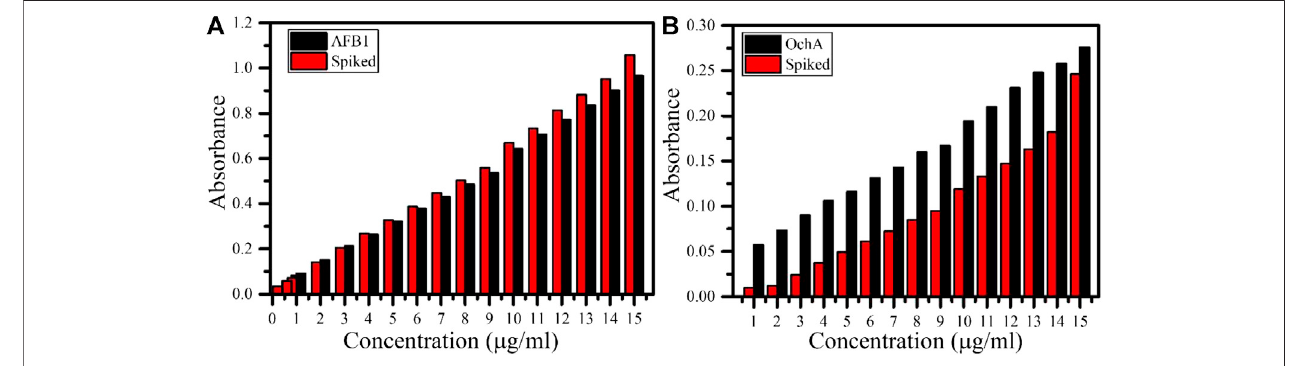
FIGURE 7 | Spiked corn sample study in comparison of (A) AFB1 and (B)